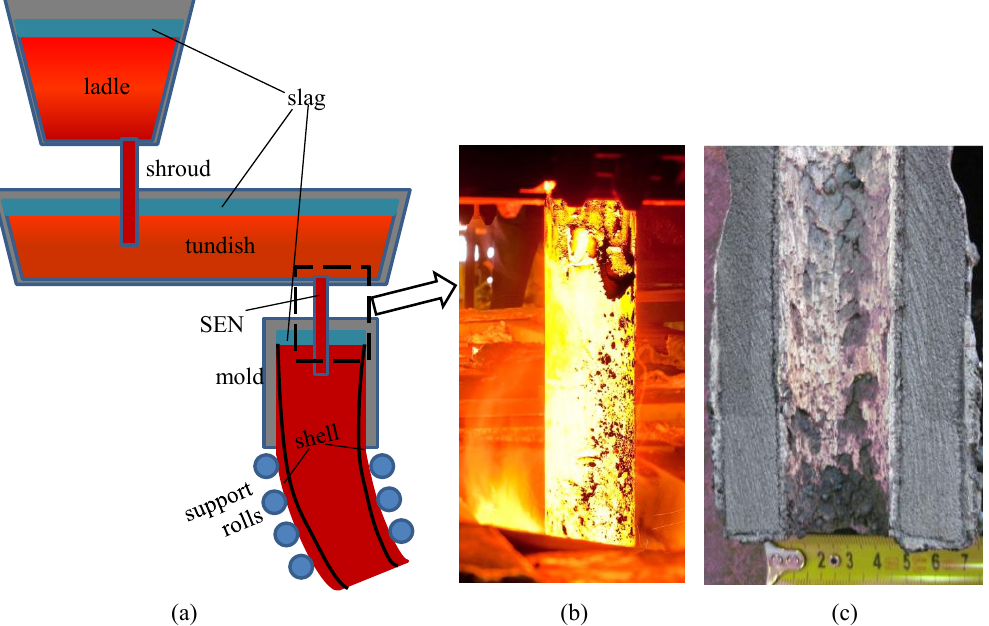
Figure 1. Continuous casting: ( a ) process schematics; ( b ) a submerged entry nozzle in operation; ( c ) a central cut of an SEN after 10 heats.